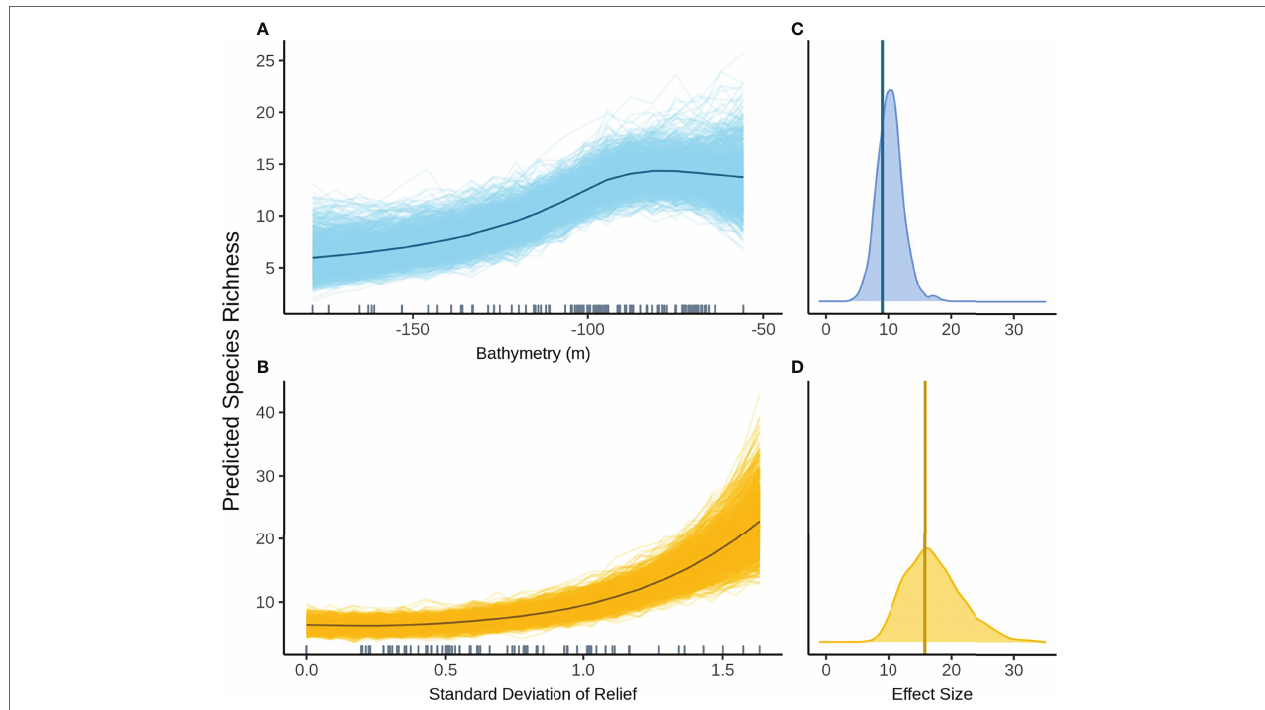
FIGURE 7 | Predicted values for the top ranked model for species richness when field of view variables were not included - (A) bathymetry (m), (B) standard deviation of relief. Density plots of effect size are also plotted for each aforementioned predictor – (C, D) respectively – with a vertical line indicating the frequentist effect size